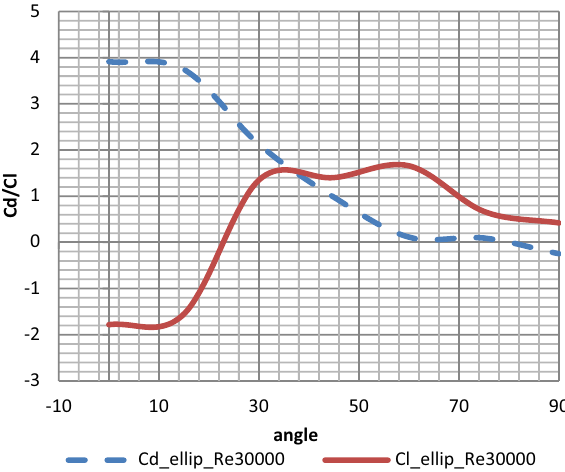
Fig. 9. Drag coefficient Cd and lift coefficient Cl against angle of wind action, for ellipse cross-section and Re=30000